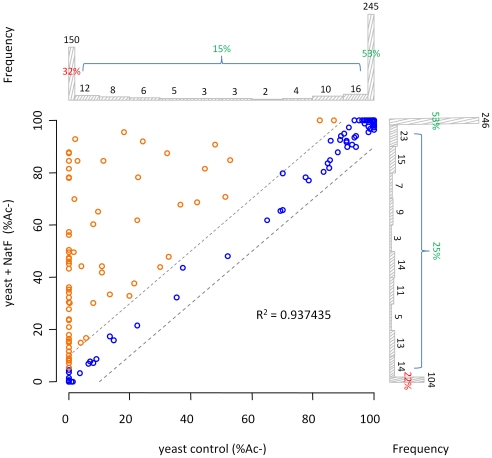
NatF N-terminally acetylates yeast substrates in vivo.Scatterplot displaying the correlation of the degrees of Nα-acetylation when comparing a control (X-axis) and a human NatF (hNaa60p)-expressing (Y-axis) yeast N-terminome dataset. The correlation was calculated with the R statistical package to be R2 = 0.937. The N-termini displaying a significant variation in the degree of Nα-acetylation (see Materials and Methods) are highlighted in orange. The frequency histograms of the number of matching data points are also shown.